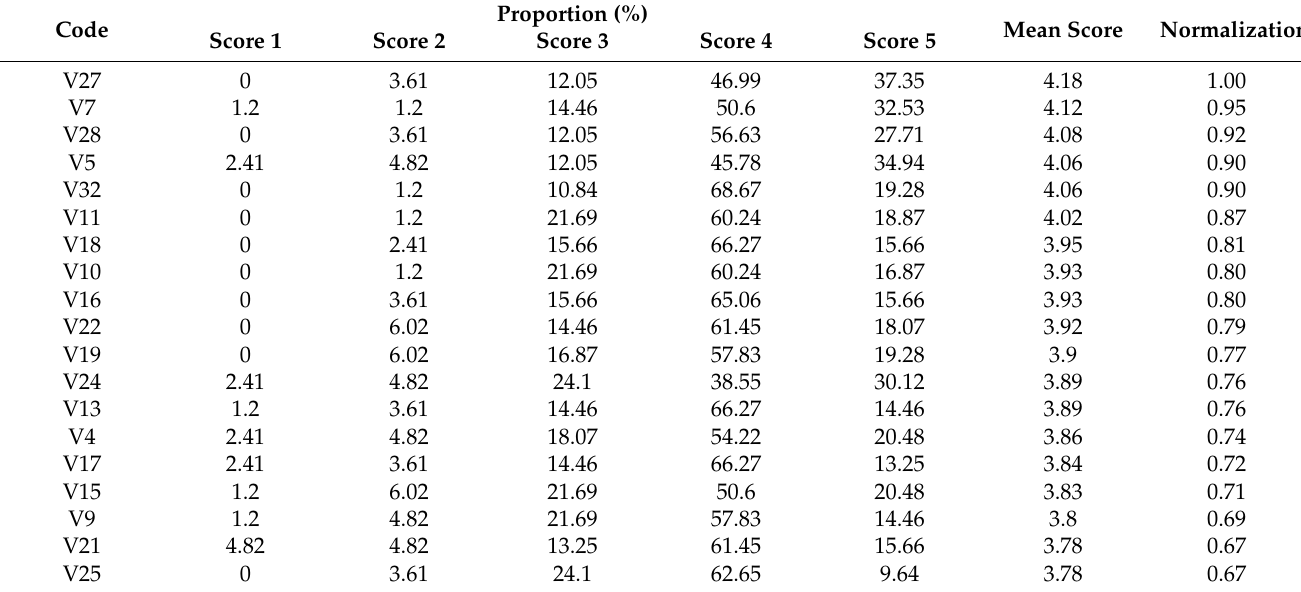
Table 5. Processing